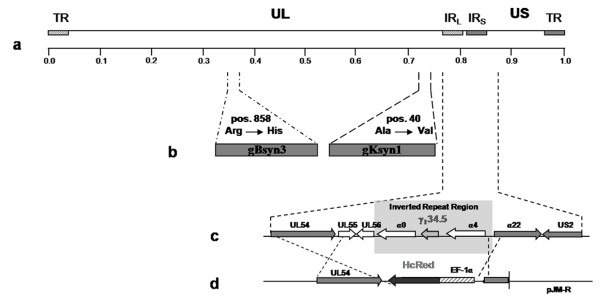
Schematic representation of the genomic structures of the oncolytic recombinant viruses OncSyn and OncdSyn. (a) Representation of the prototypic arrangement of the HSV-1 genome with the unique long (UL) and unique short (US) regions flanked by the terminal repeat (TR) and internal repeat (IR) regions. (b) Approximate locations of the gB and gK genes. (c) An expansion of the inverted repeat region showing the approximate locations of UL54, UL55, UL56, α 0, γ134.5, α 4, α 22 and US2 genes. (d) Schematic of the DNA fragment cloned into plasmid pJM-R, which was used for insertion of the HcRed gene cassette into the viral genome in place of the NV1020 genomic deletion as described in Materials and Methods.